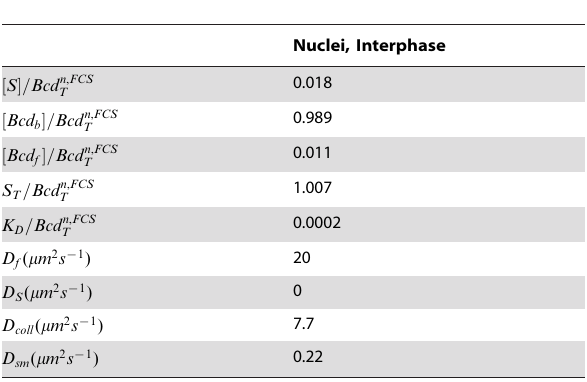
Table 3. Estimates of equilibrium concentrations and of model parameters derived from experiments performed in